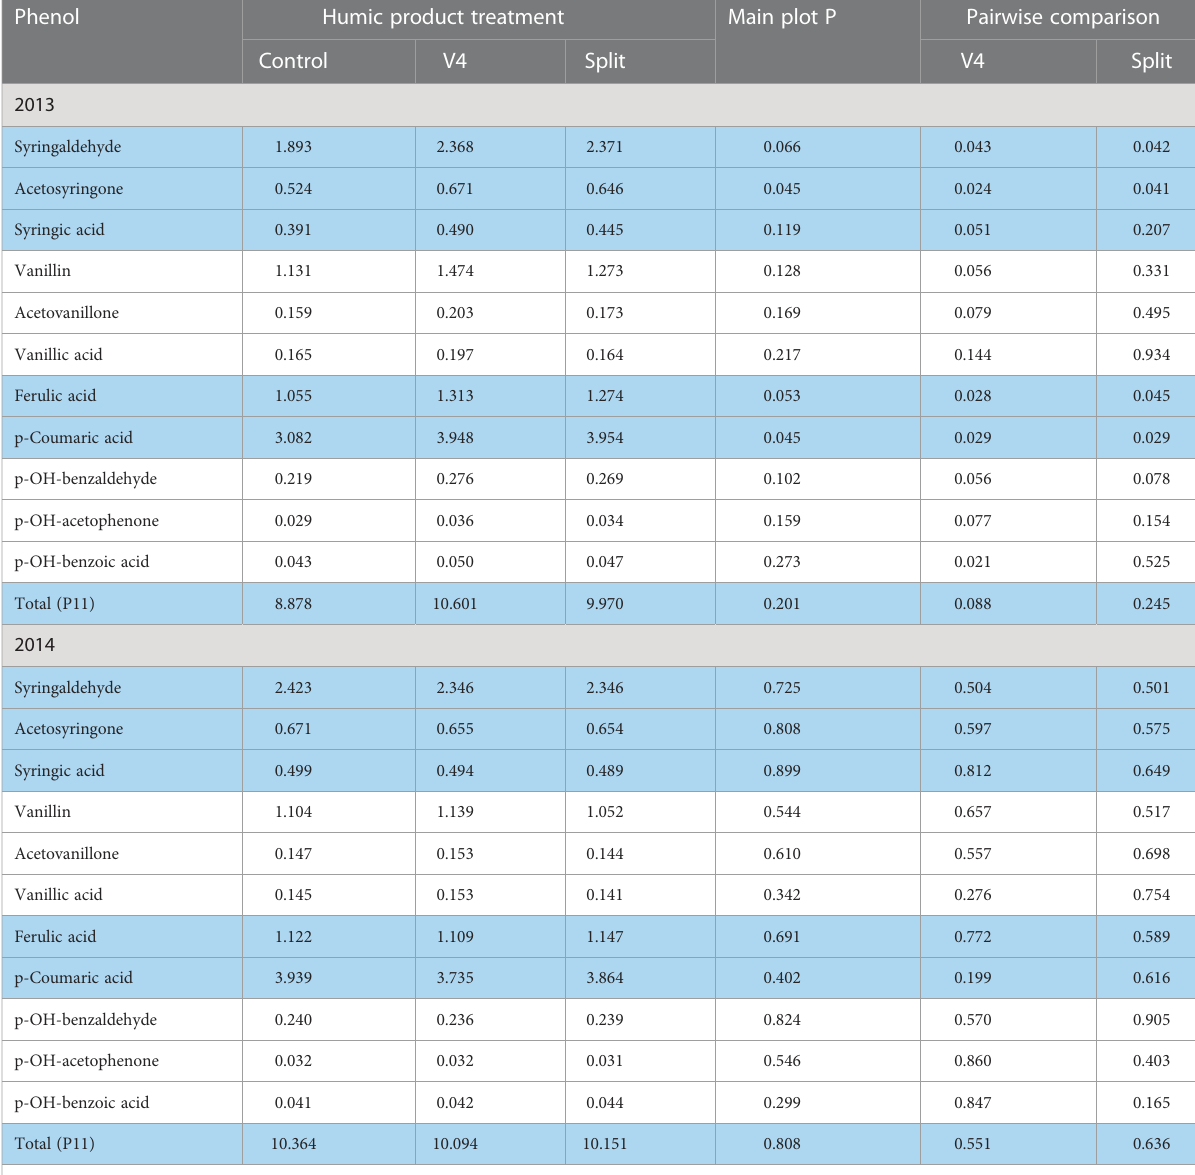
Color coding represents phenol